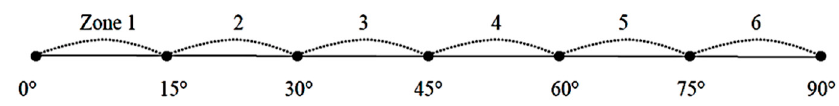
Figure 3. An FRP onset index of muscles used in this study during full trunk flexion.